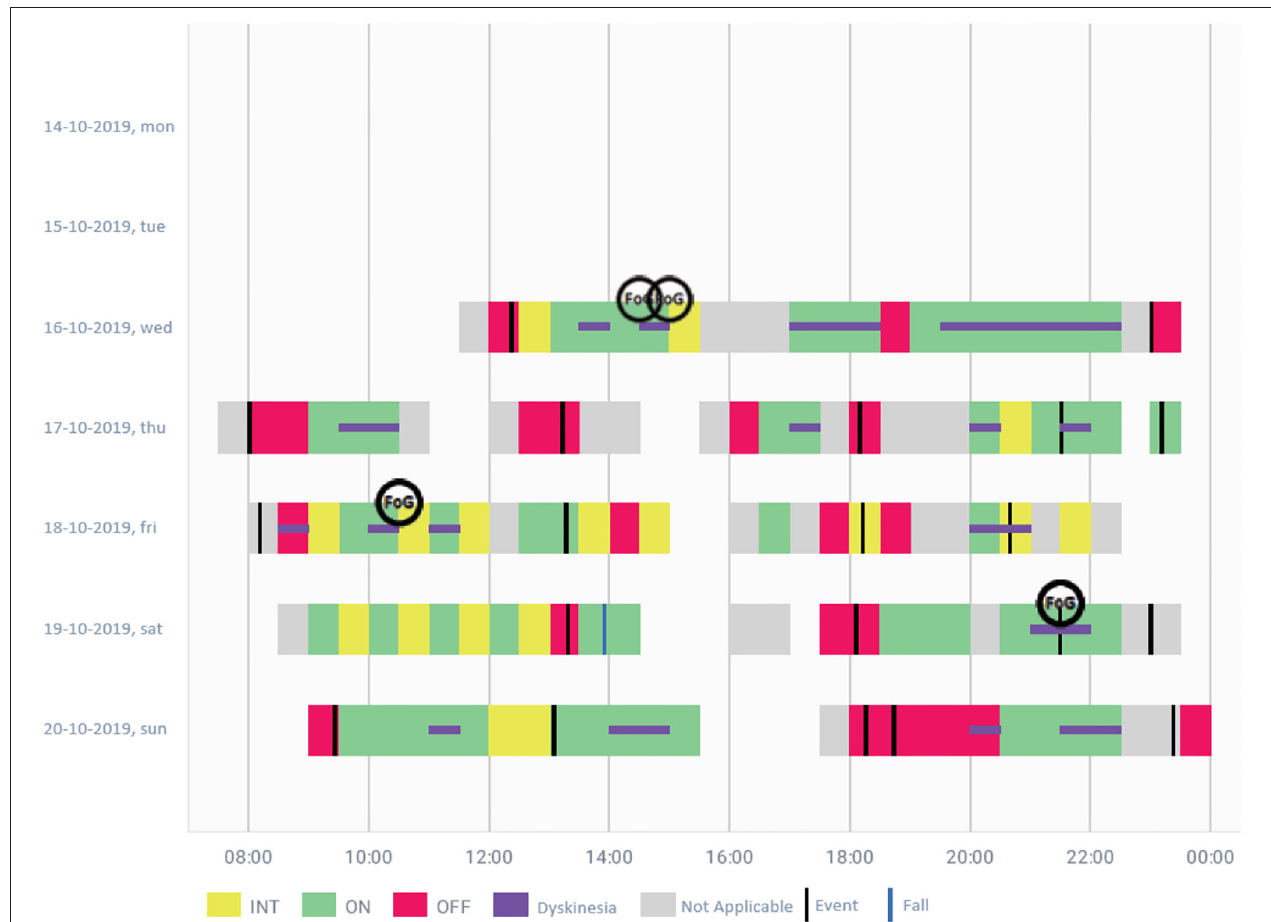
FIGURE 5 | An example of the distribution of symptoms (hourly distribution of symptoms along different days following the established color code), one of the graphics generated by STAT-ON TM . This patient has a concurrent OFF zone every day around 18:00. It is clear when the patient rests at 15:00 or 16:00 every day. The OFF and dyskinesia are significant, but the FoG only appears 4 times, being practically insignificant and should be contrasted with the patient. The black line is when the button was pushed, in this case when the patient took the medication.